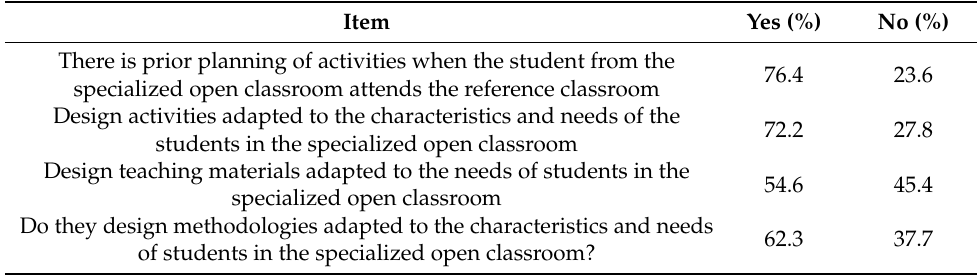
Table 7. Planning of activities for SOC